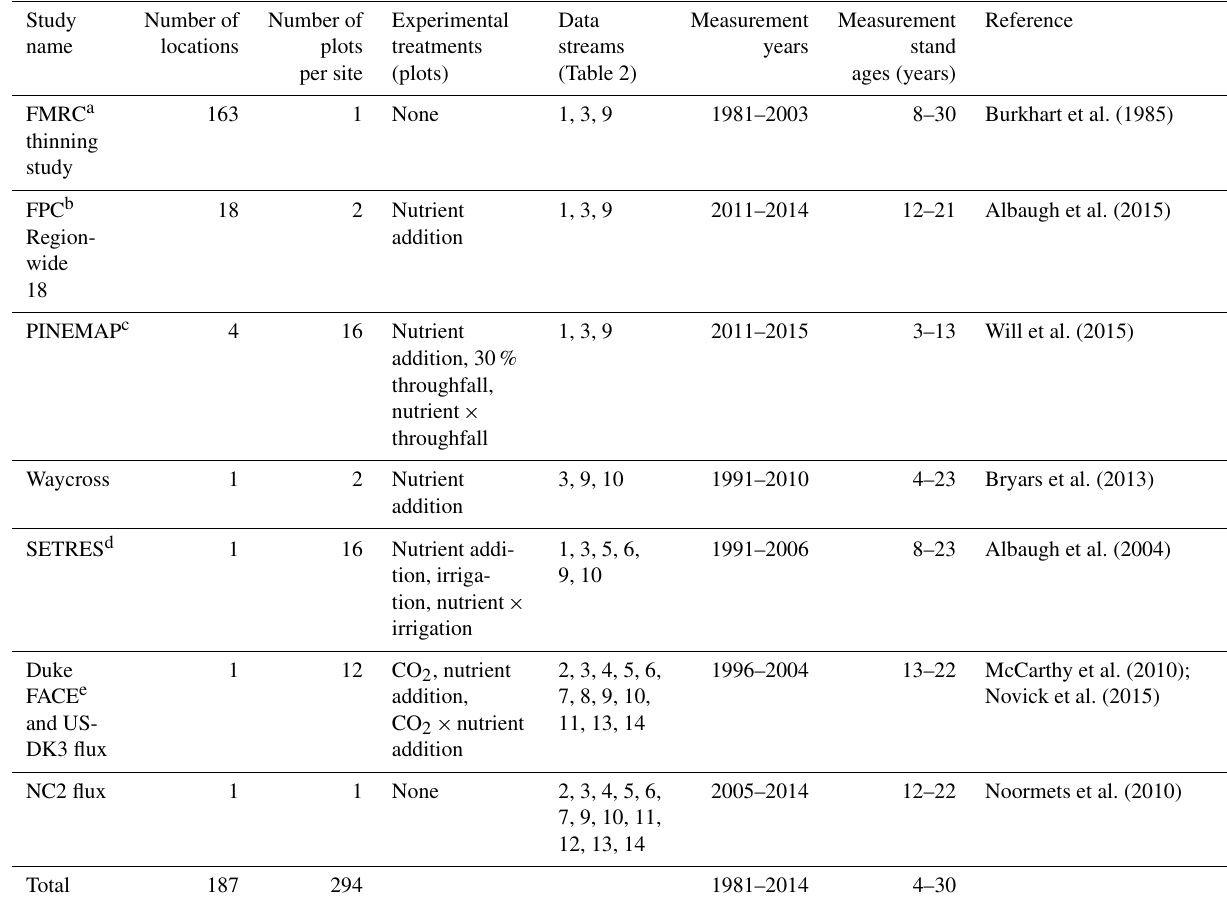
Table 2. Descriptions of the studies used in data assimilation. Study Number of Experimental Data Measurement Measurement